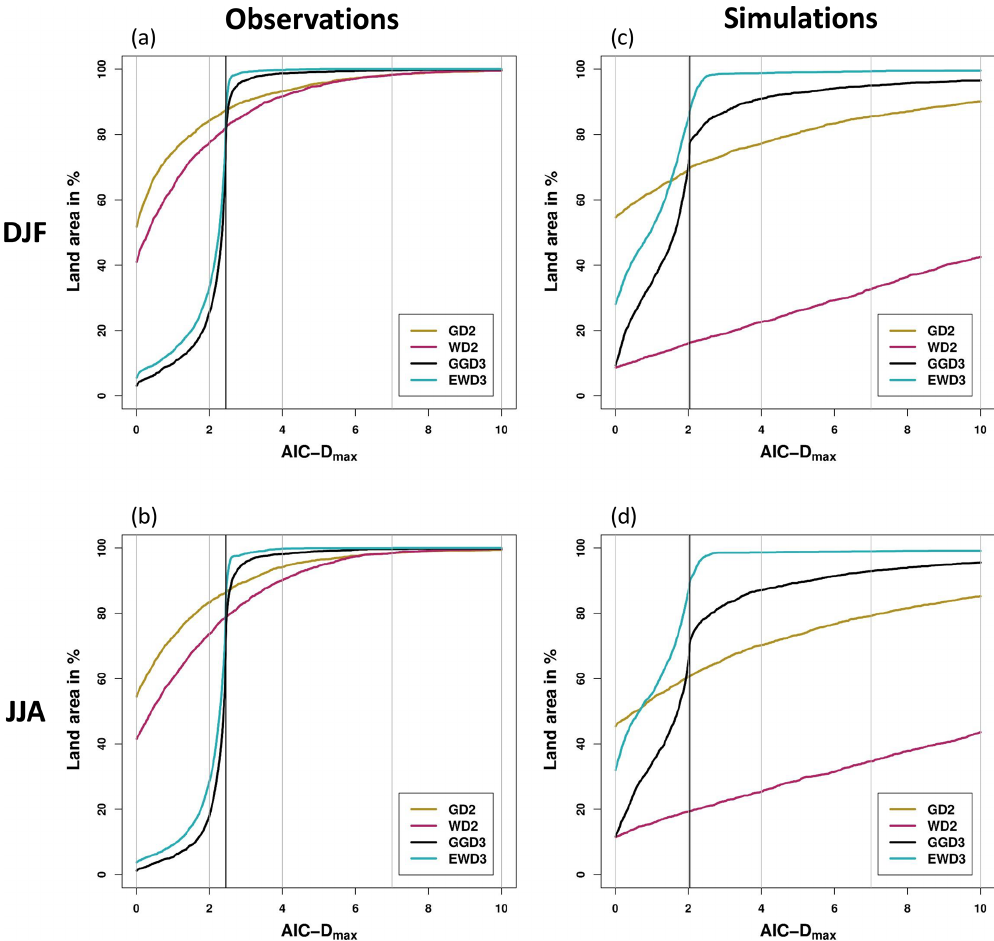
Figure 5. AIC-D frequencies: percentages of global land grid points in which each distribution function yields AIC-D values that are smaller than or equal to a given AIC-D max value. The vertical black line indicates the different complexity penalties between three- and two- parameter PDFs. AIC-D frequencies are displayed for each candidate PDF for observations (a, b) and simulations (c, d) during DJF (a, c) and JJA (b, d)